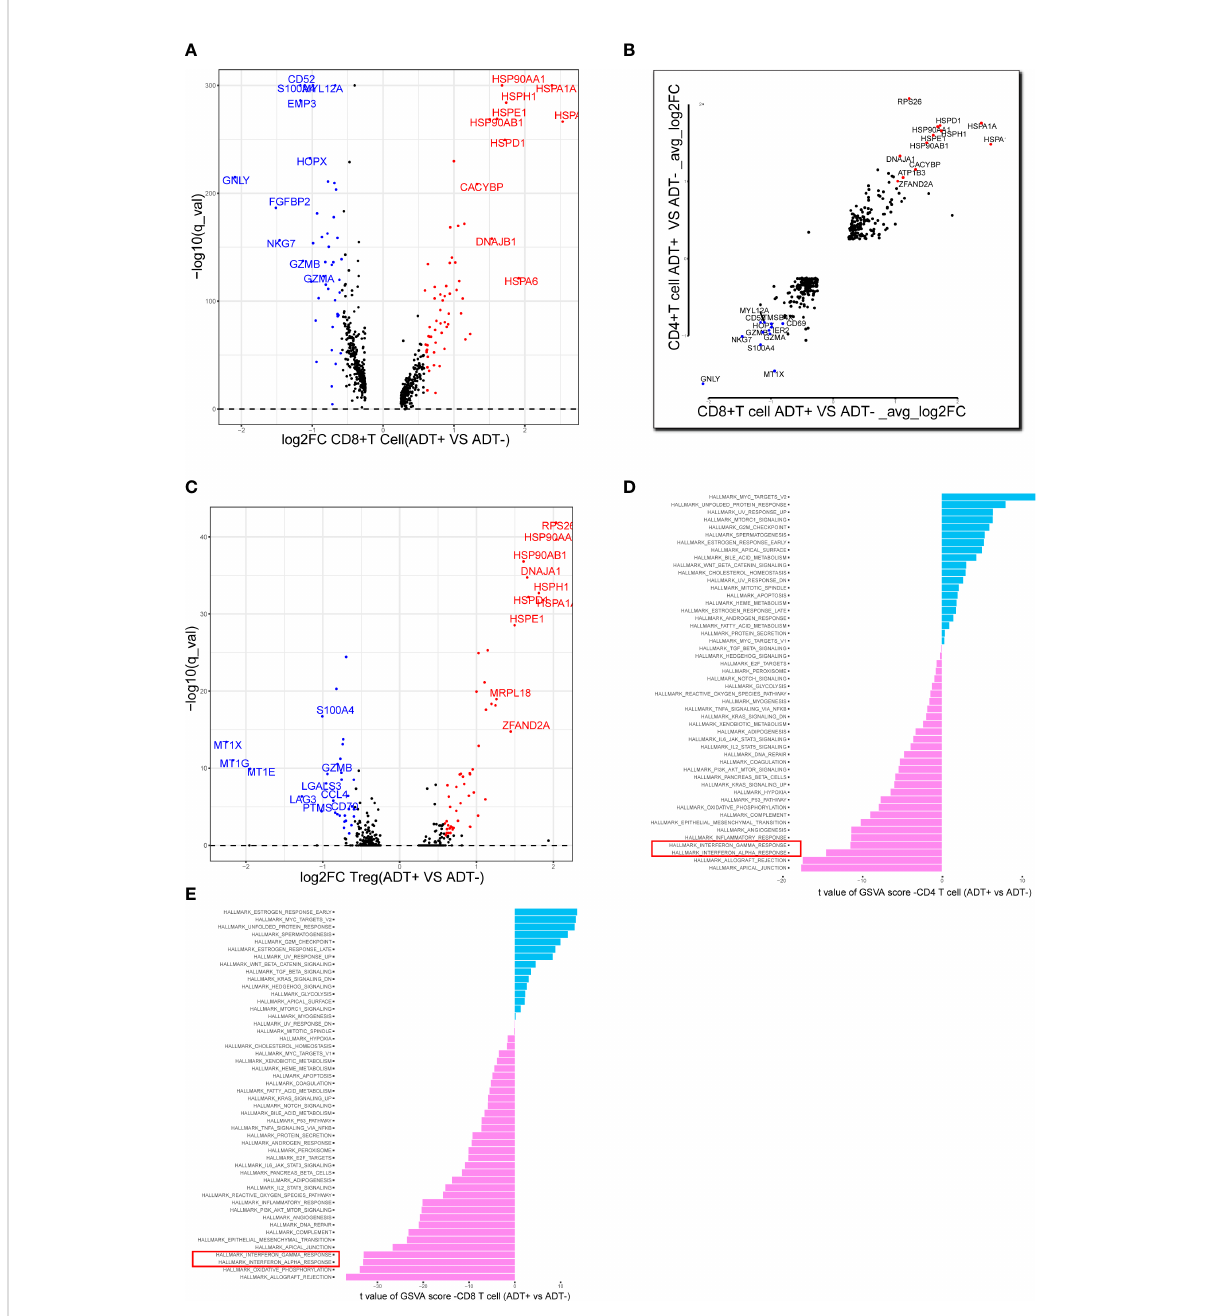
FIGURE 3 Assessing the functional states of tumor-in fi ltrating T cells in prostate cancer. (A) Volcano plot showing DEGs in ADT-derived cytotoxic T cells in comparison with those derived from without ADT tissues. Representative genes are labeled. (B) Scatterplot showing DEGs in ADT-derived CD8+ and CD4+ T cells in comparison with those derived from without ADT tissues. Representative genes are labeled. (C) Volcano plot showing DEGs in ADT-derived Treg cells in comparison with those derived from without ADT tissues. Representative genes are labeled. (D, E) GSVA bar plots comparing the activities of 50 hallmarks between tissue with and without ADT-derived CD4+ and CD8+ T